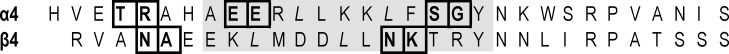
Sequences of the amino-terminal regions of the subunits studied.The sequences of the mature subunit from the predicted amino-termini are shown for the human nicotinic α4 and β4 subunits are shown. The locations of insertions are shown by the boxed residues (e.g. insertions were made between α4 T4 and R5). The region indicated by gray shading is likely to be α-helical based on alignments to related subunits of known structure (see Text for details). The two leucine residues shown in italics are residues identified as important for expression in the nicotinic α7 subunit (see Text).